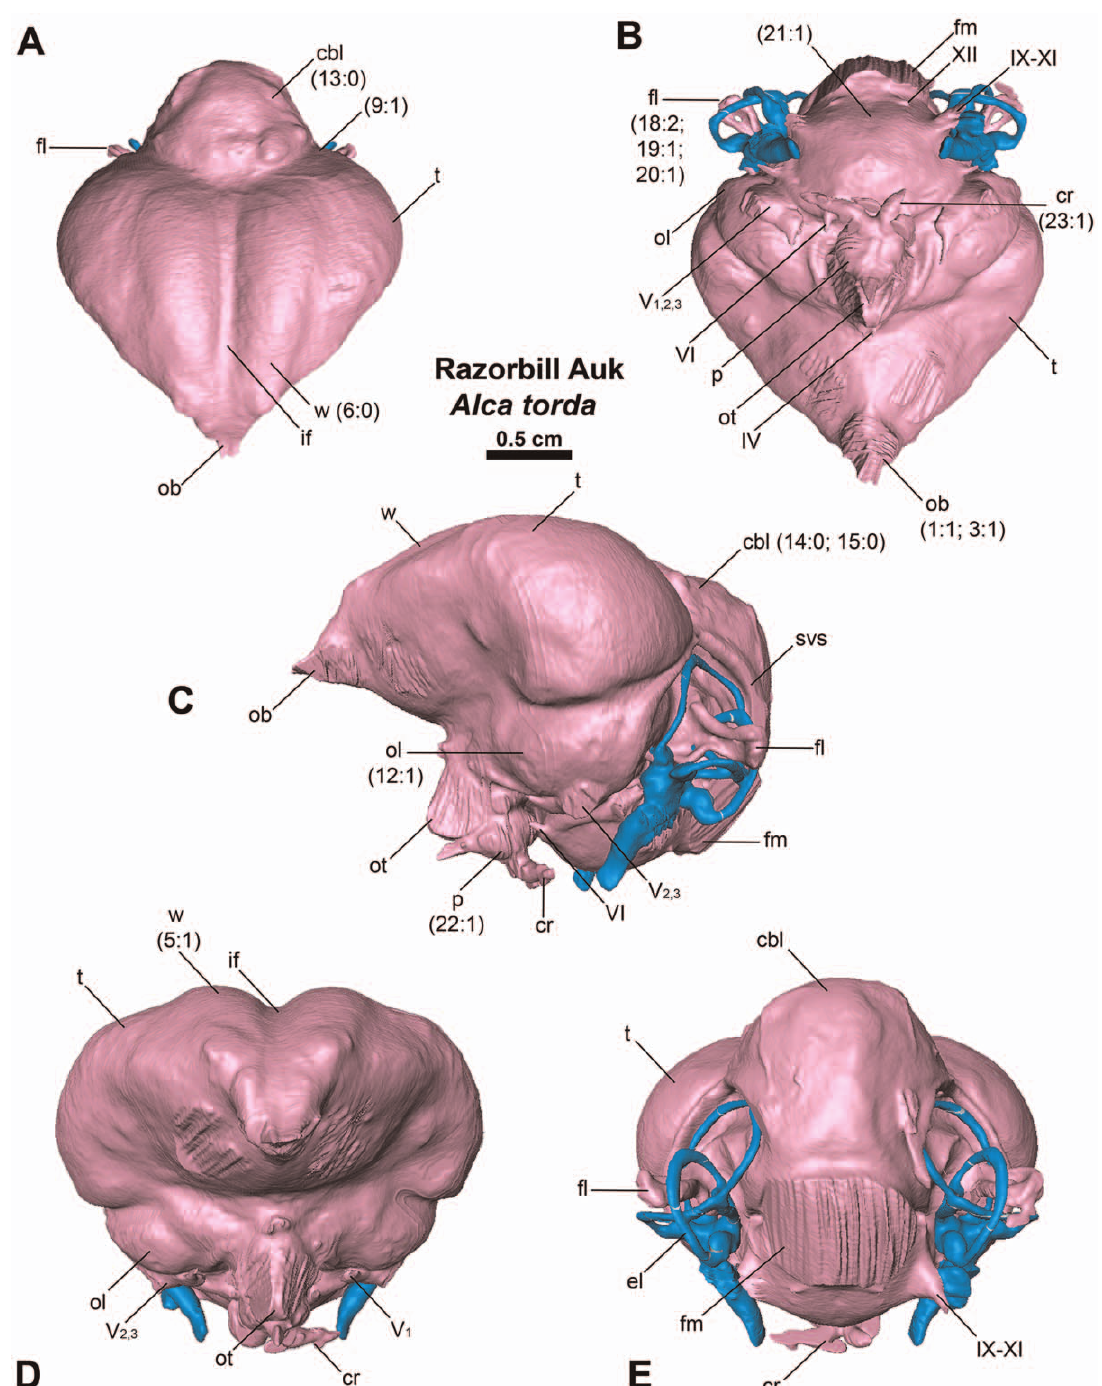
Figure 2. Endocast of the Razorbill Auk Alcatorda in dorsal (A), ventral (B), lateral (C), anterior (D), and posterior (E) views. Numbers in parentheses represent character states from Appendix S1.